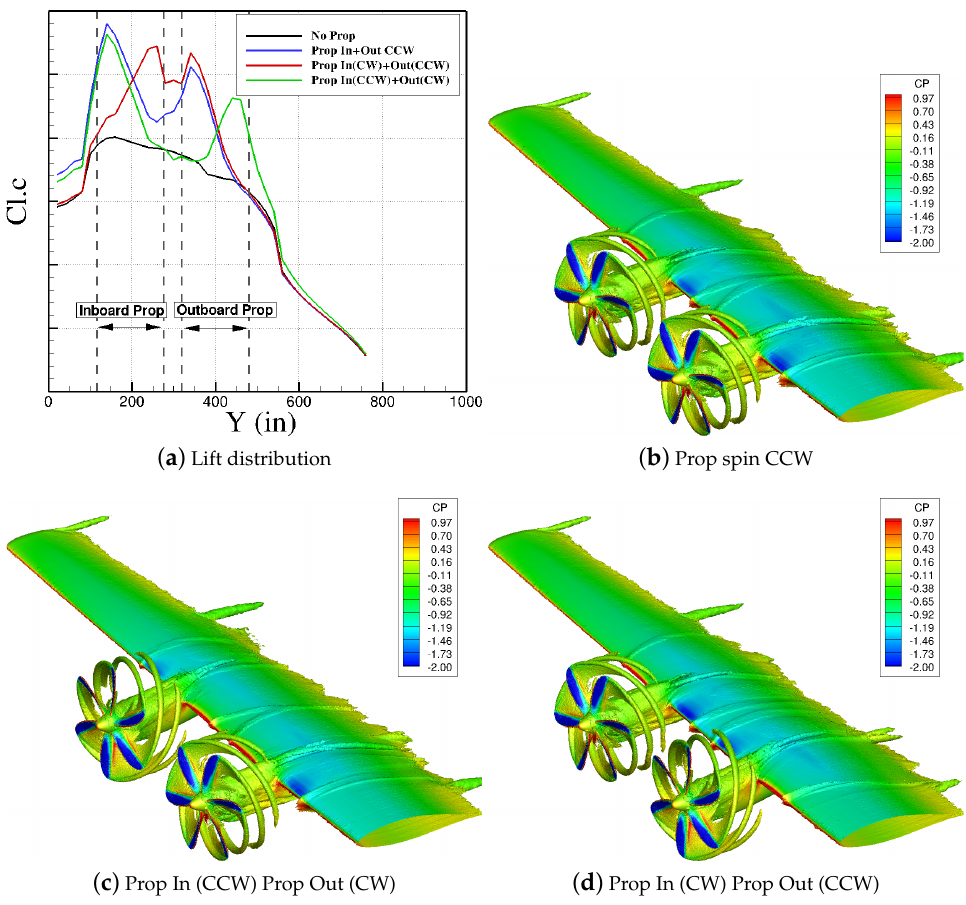
Figure 13. Propeller installed on both inboard and outboard wings, but they spin at different directions.